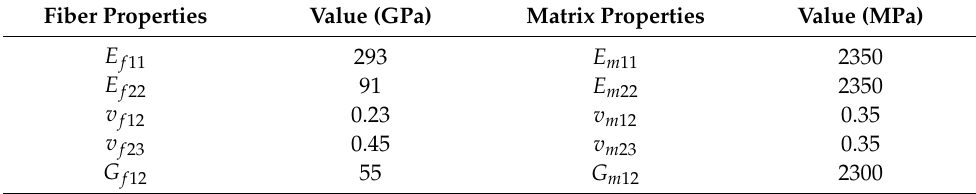
Table 4. Elastic properties of the composite constituents.